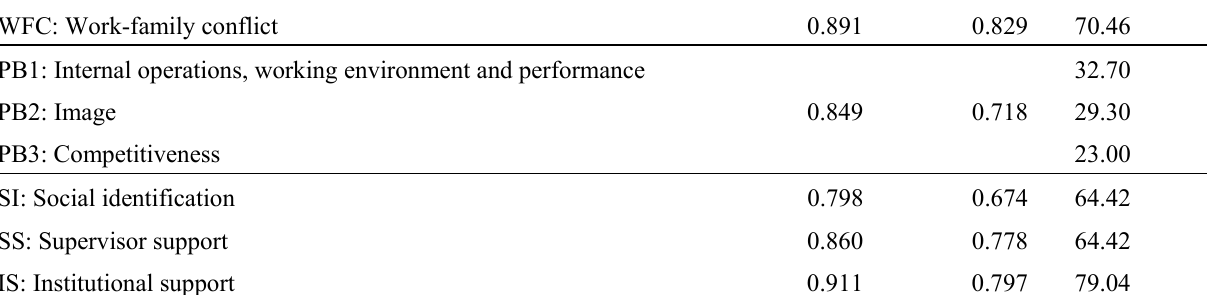
Cronbach’s KMO Explained Alpha Test